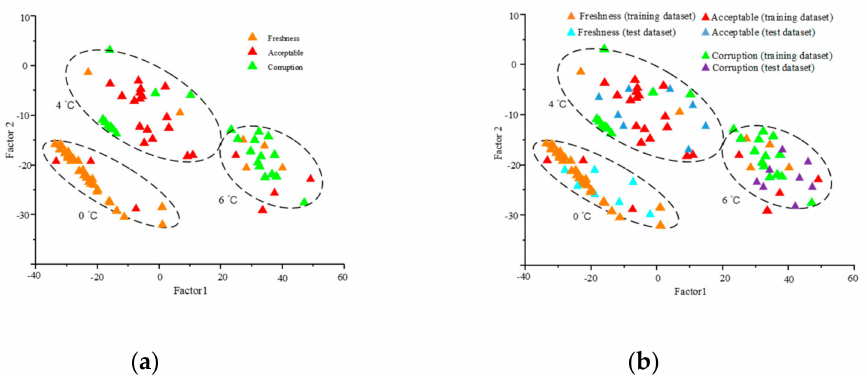
Figure 10. The freshness grading results stored at refrigerated temperature (0 ◦ C, 4 ◦ C, 6 ◦ C). ( a ) The freshness grading results of training dataset; ( b ) the freshness grading results of training dataset and test dataset.